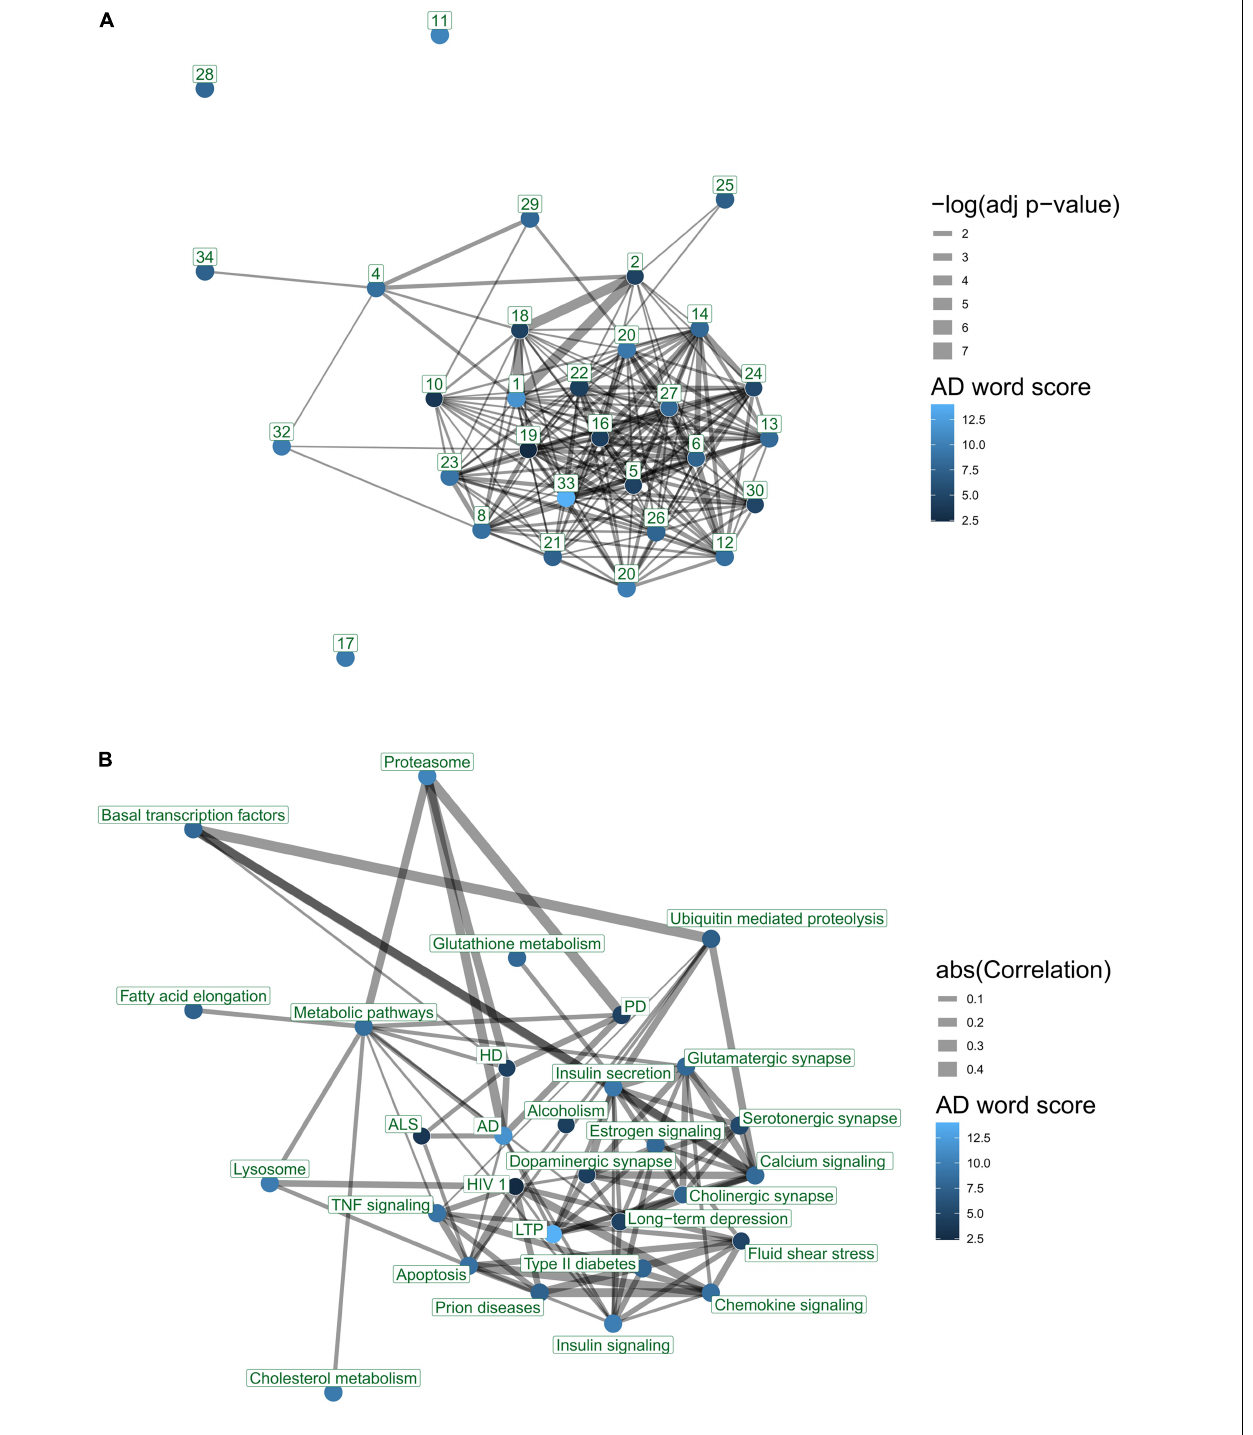
Frontiers in Aging Neuroscience |